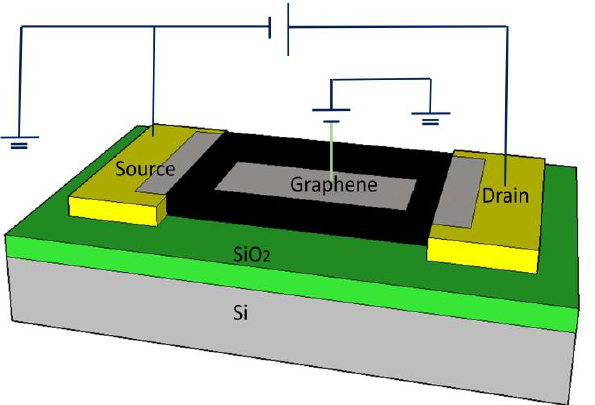
Figure 1. The schematic figures of our FET biosensor design. The detection target is an organophosphorus sample; the periphery circuit helps to conduct the measurement.